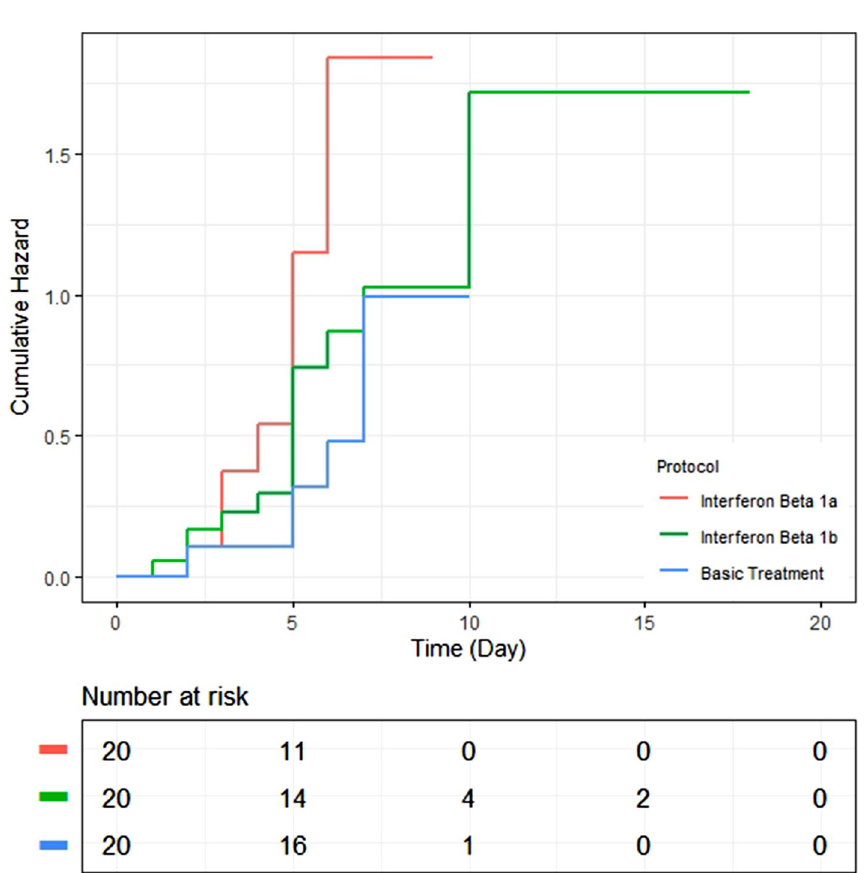
Figure 3. Time to clinical improvement in the intention-to-treat